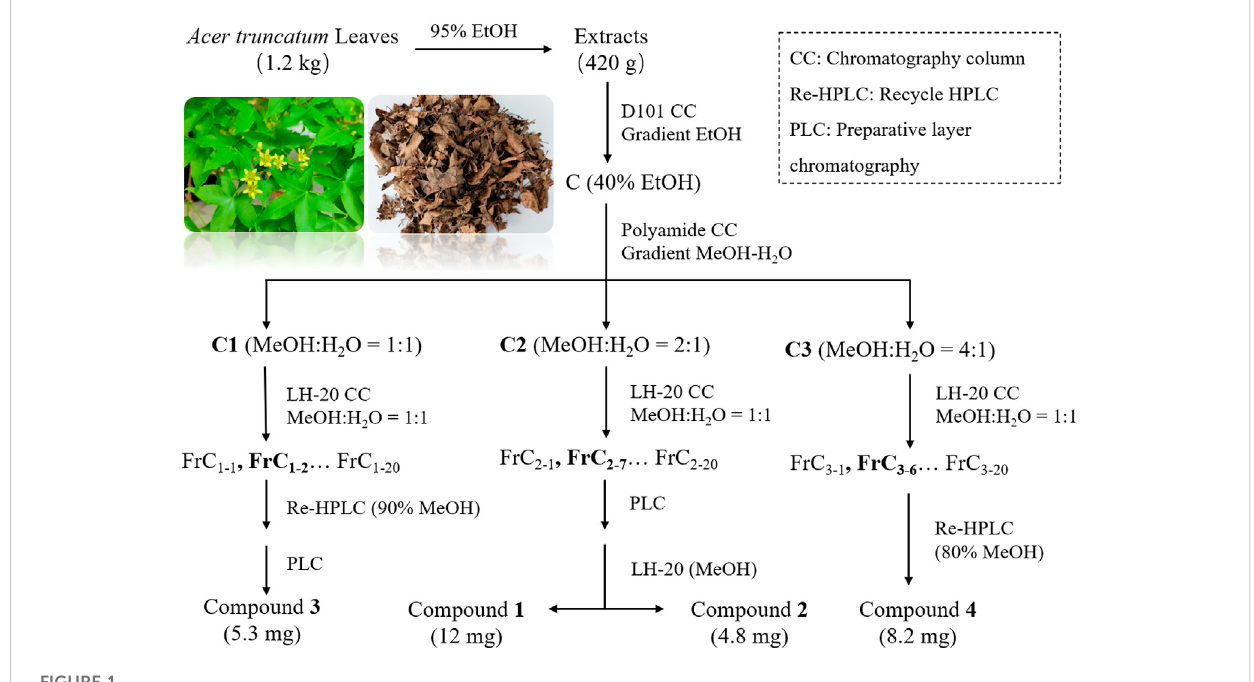
Schematic diagram of compound 1-4 isolation.